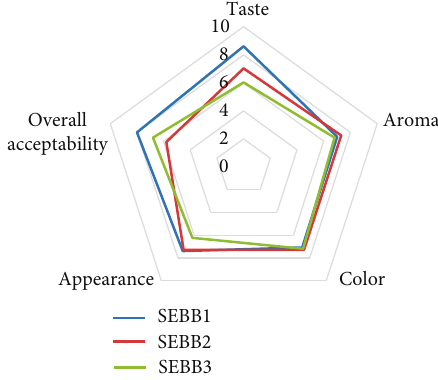
Figure 2: The results of the sensory evaluation for the nutraceutical beverage from sa ff ron SEBB 1 containing 65 g of sucrose per 500ml, SEBB 2 containing 17.5 g, and SEBB 3 containing 79.5